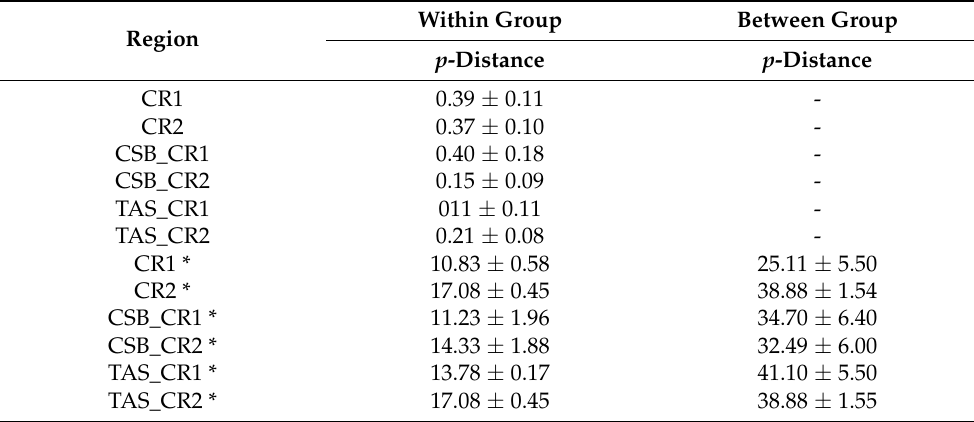
ulatus ; Deraniyagala